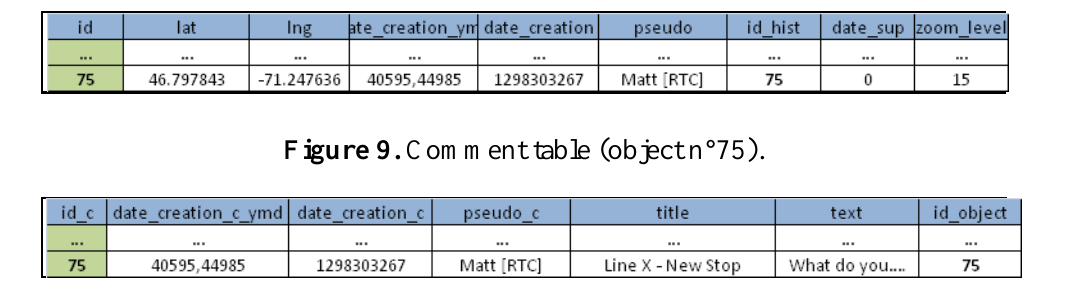
Figure 8. Marker table (object n°75).